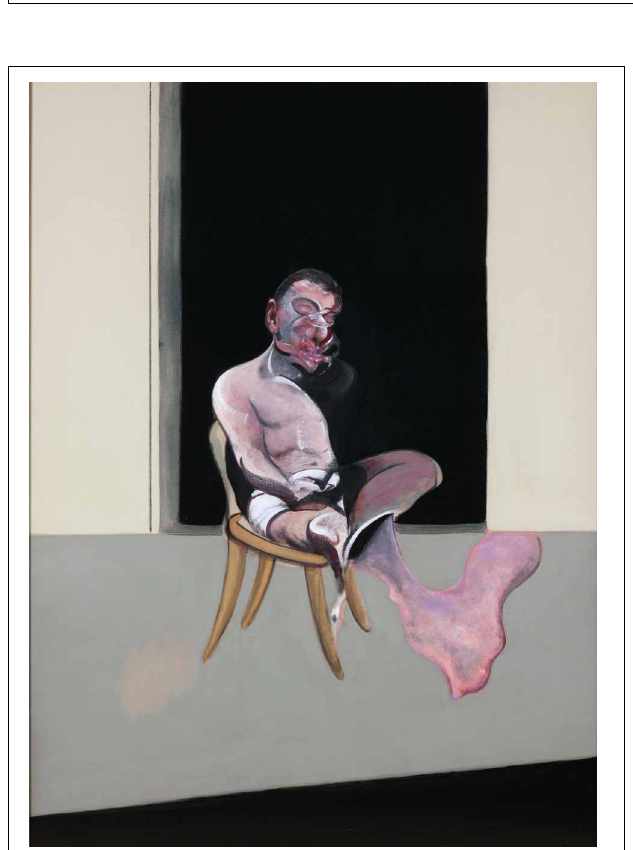
FIGURE 13 | Francis Bacon— Sphinx—Portrait of Muriel Belcher, 1979. © The Estate of Francis Bacon. All rights reserved. DACS 2013.